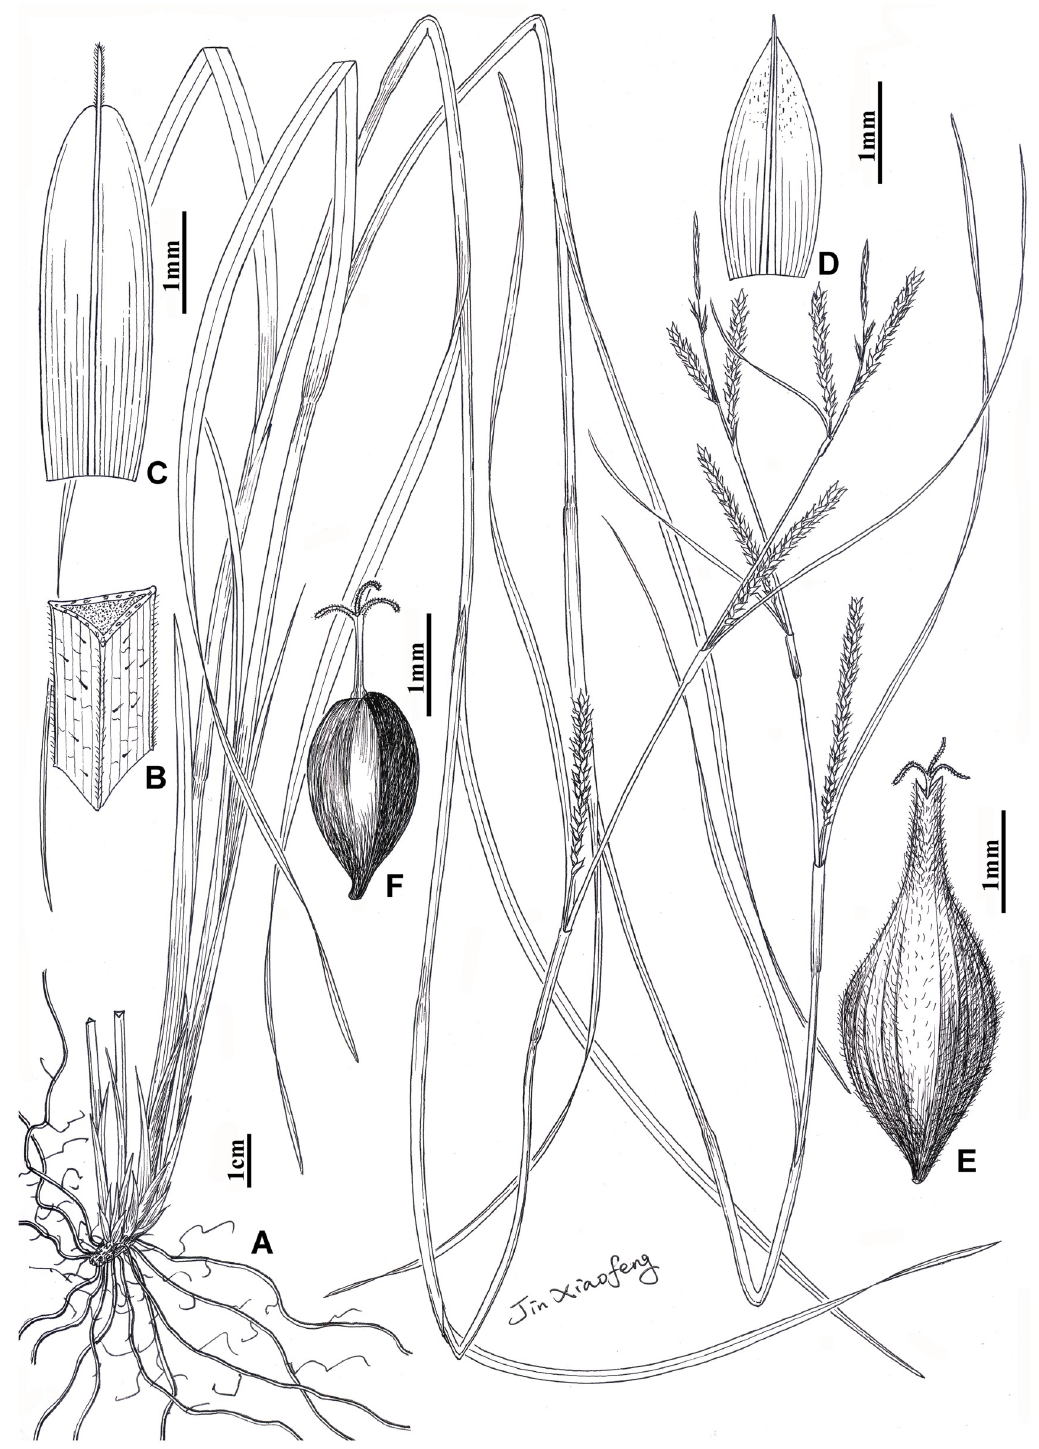
Fig 5. Carex borealifujianica . A, habit; B, indumentum on leaf sheath; C, staminate scale; D, pistillate scale; E, utricle; F, achene.